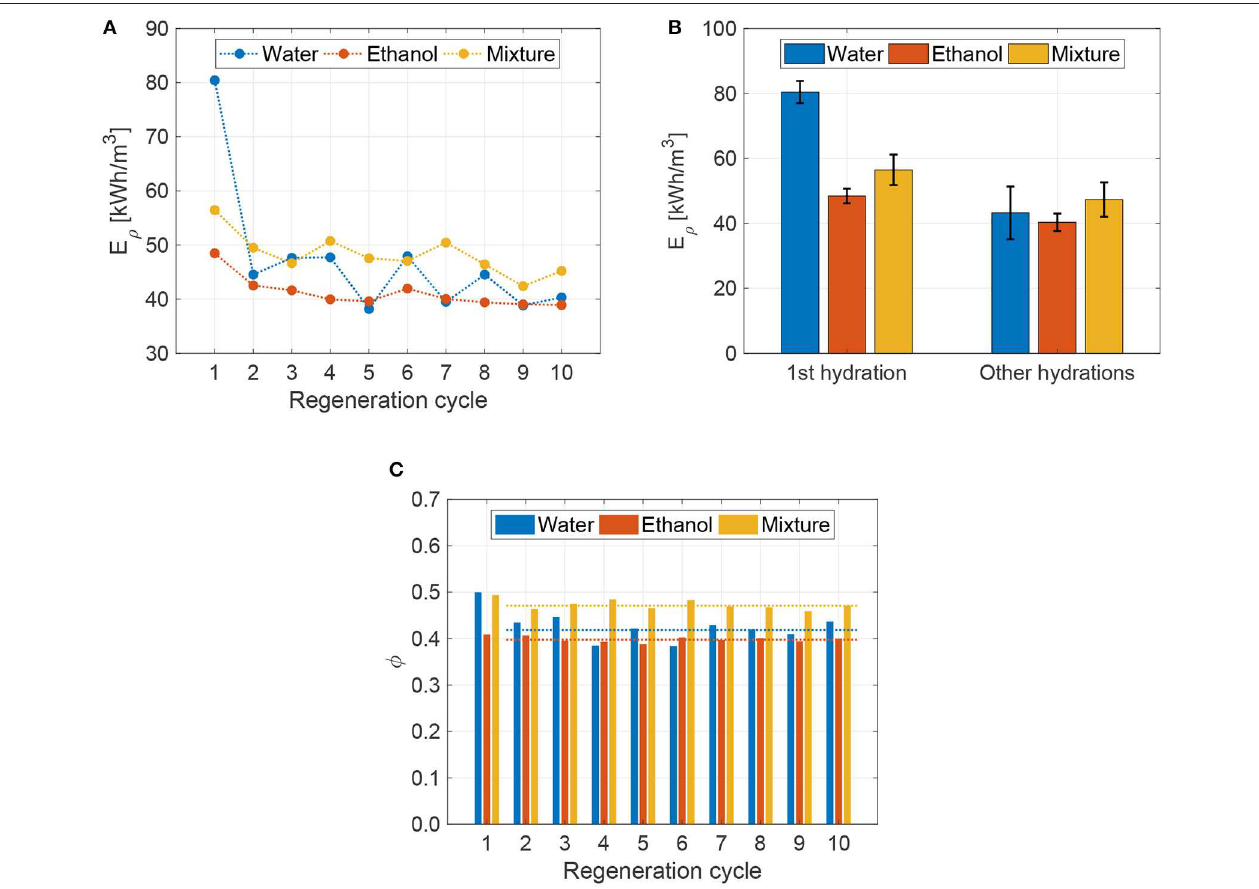
FIGURE 5 | (A) Heat storage density obtained for the tested 13X zeolite as a function of the regeneration cycle for the different sorbates (water, ethanol and 30:70%wt. ethanol-water mixture), and (B) relative average values (first hydration and successive nine hydration cycles, where results are reported in terms of mean ± 2 standard deviation). (C) Loaded liquid fraction at ambient pressure ( p = 1 bar) and temperature ( T = 20 ◦ C) on regenerated zeolite samples. In these experiments, hydrated zeolite samples have been regenerated at 250 ◦ C for 20 min. Note that the first regeneration cycle reports the heat storage density and hydration capacity of pristine zeolite samples, as provided by the